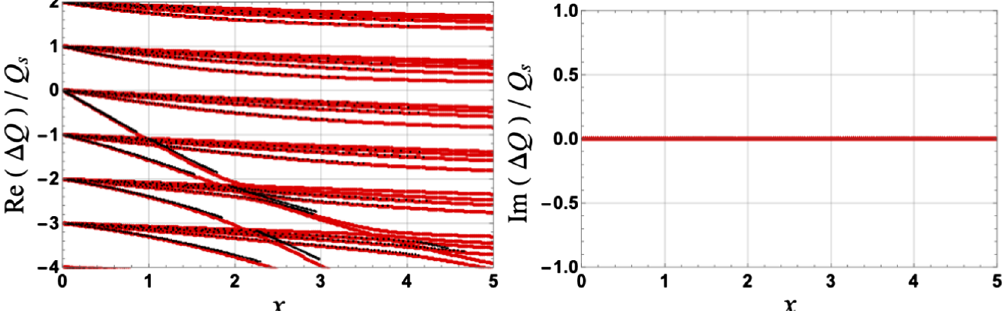
FIG. 2. Comparison between GALACTIC (in red) and Laclare [29] (in black) of the normalized mode-frequency shifts, in the case of a pure inductive impedance and for a water-bag (WB) longitudinal distribution [29]: (left) real part and (right) imaginary part (from GALACTIC only).